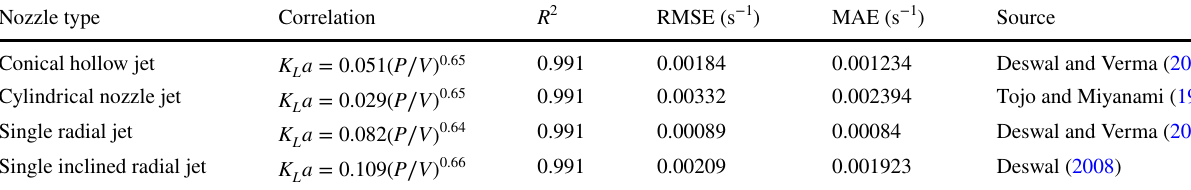
Table 5 R 2 RMSE (s −1 ) and MAE (s −1 ) of proposed correlations with testing data set